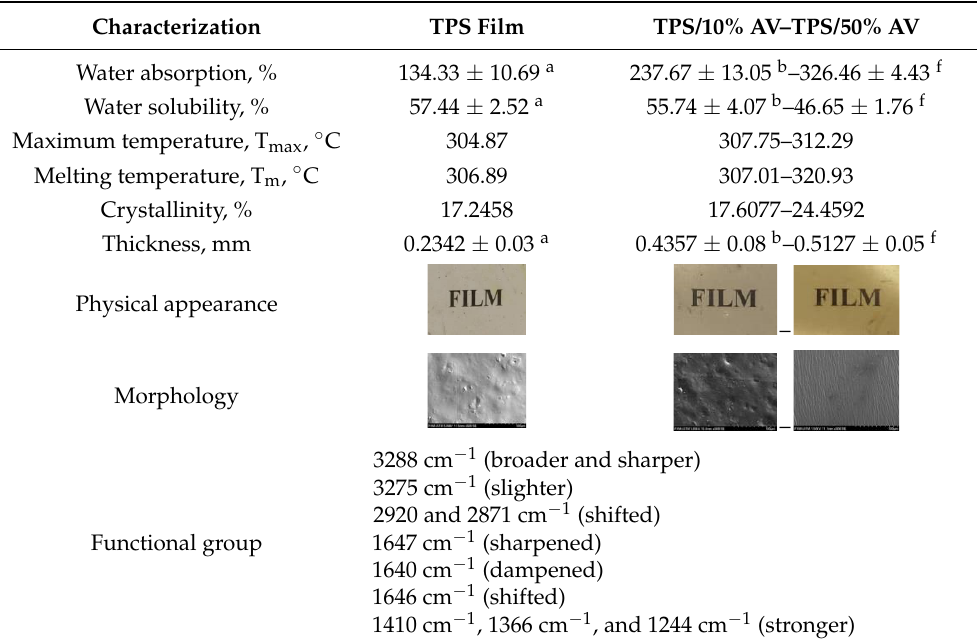
Table 2. Summary of results.